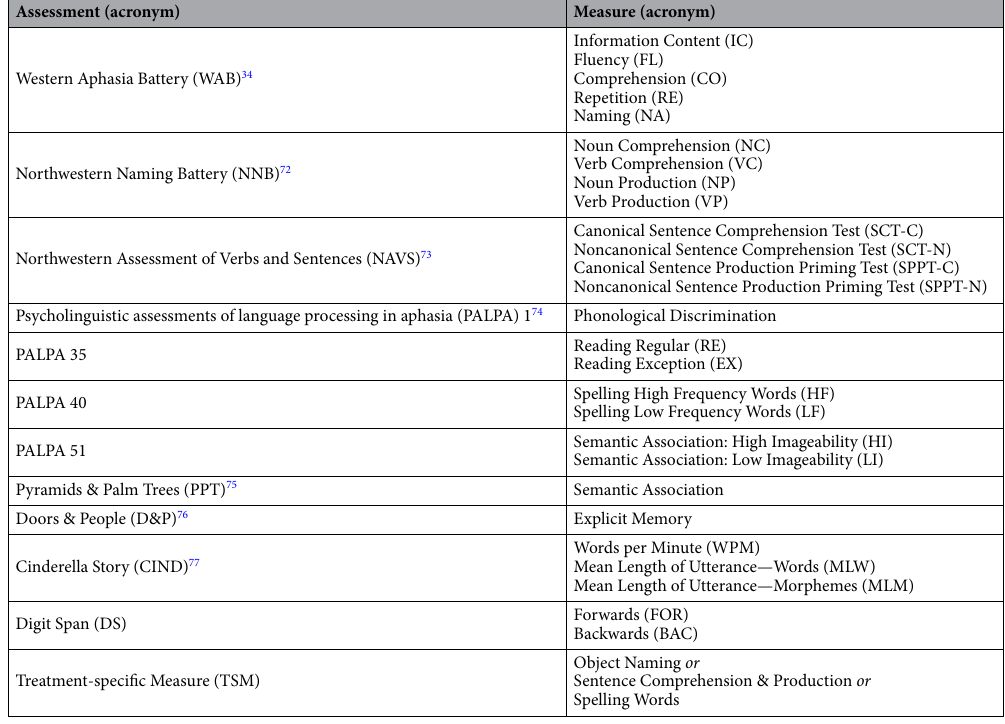
Table 1. Aphasia assessment battery. All 27 behavioral measures comprising 11 language and cognitive assessments are shown. Each measure has a corresponding acronym constructed by hyphenating the assessment acronym with the individual measure acronym (i.e. the WAB-IC correspond to the Western Aphasia Battery, Information Content), except for measures in the NAVS which are referred to only by their measure